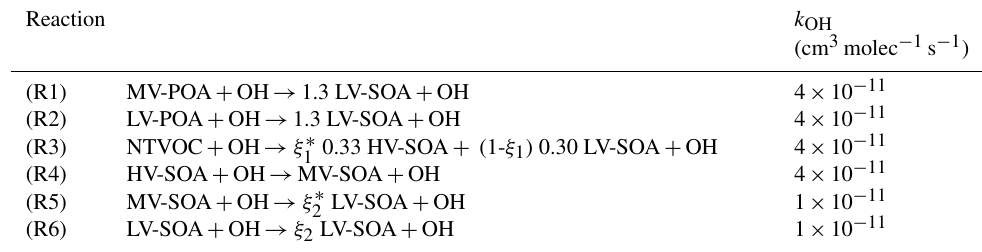
Table 2. Reactions representing the evolution of BB OA in the simplified VBS scheme and their OH reaction rates ( k OH ).